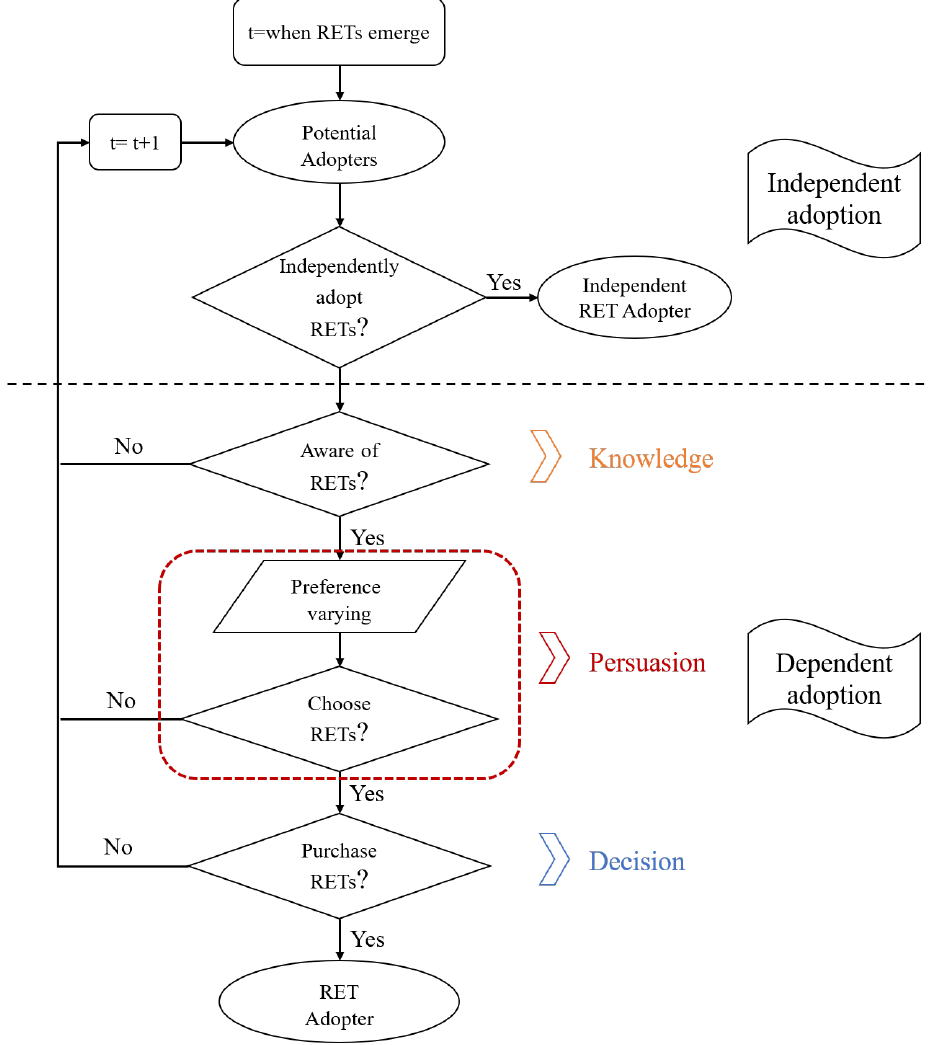
Figure 4. Flowchart of the model. RETs, renewable energy